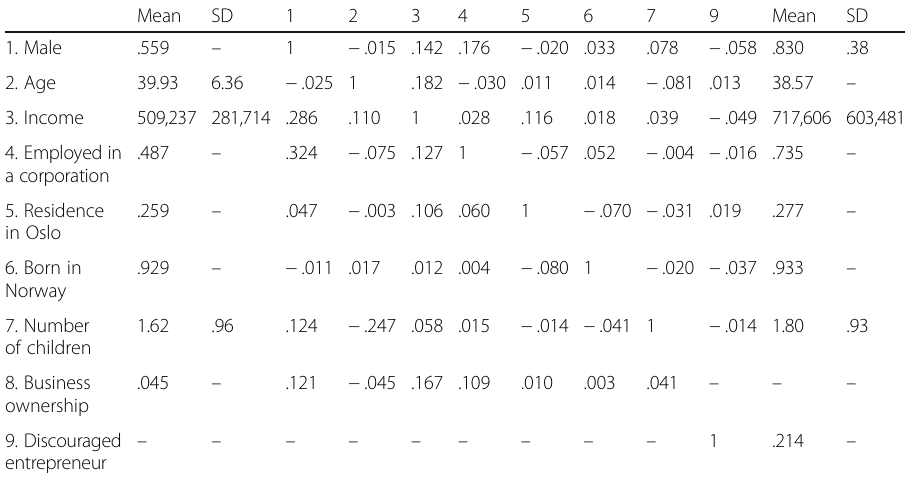
Table 4 Descriptive statistics and correlations among the analysis